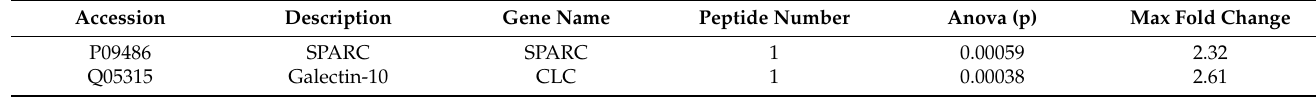
Table 4. Candidate risk stratification markers identified by exploratory proteomic